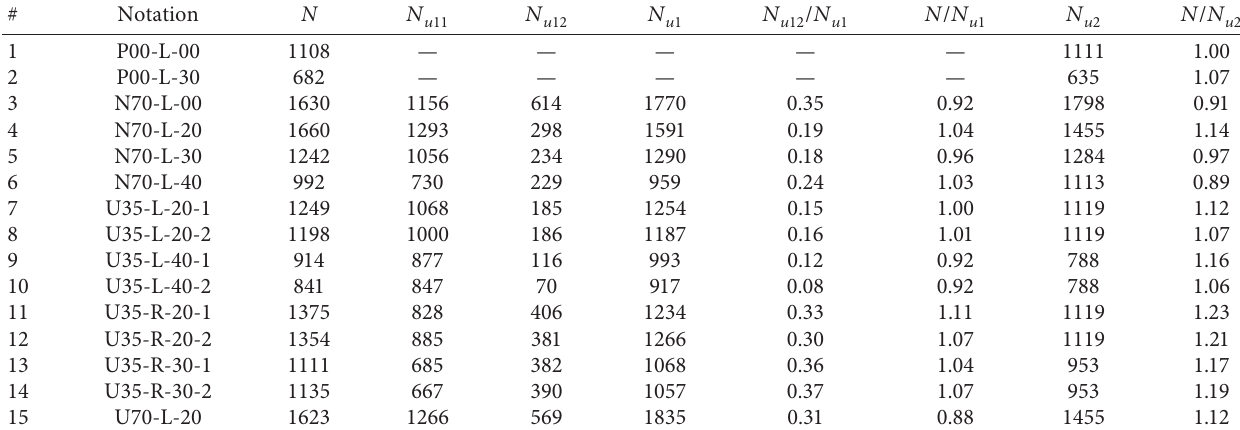
Table 7: Measured and calculated value of segment